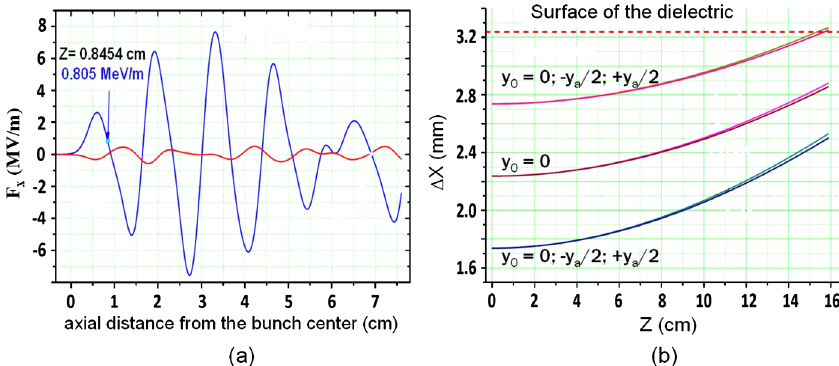
FIG. 6. (a) Axial profile of the composite horizontal force F x ( y ¼ 0 ) along the center of the acceleration channel (blue curve) and the center of the drive channel (red); and (b) the horizontal ( x ) position of test particles as they move along the structure.